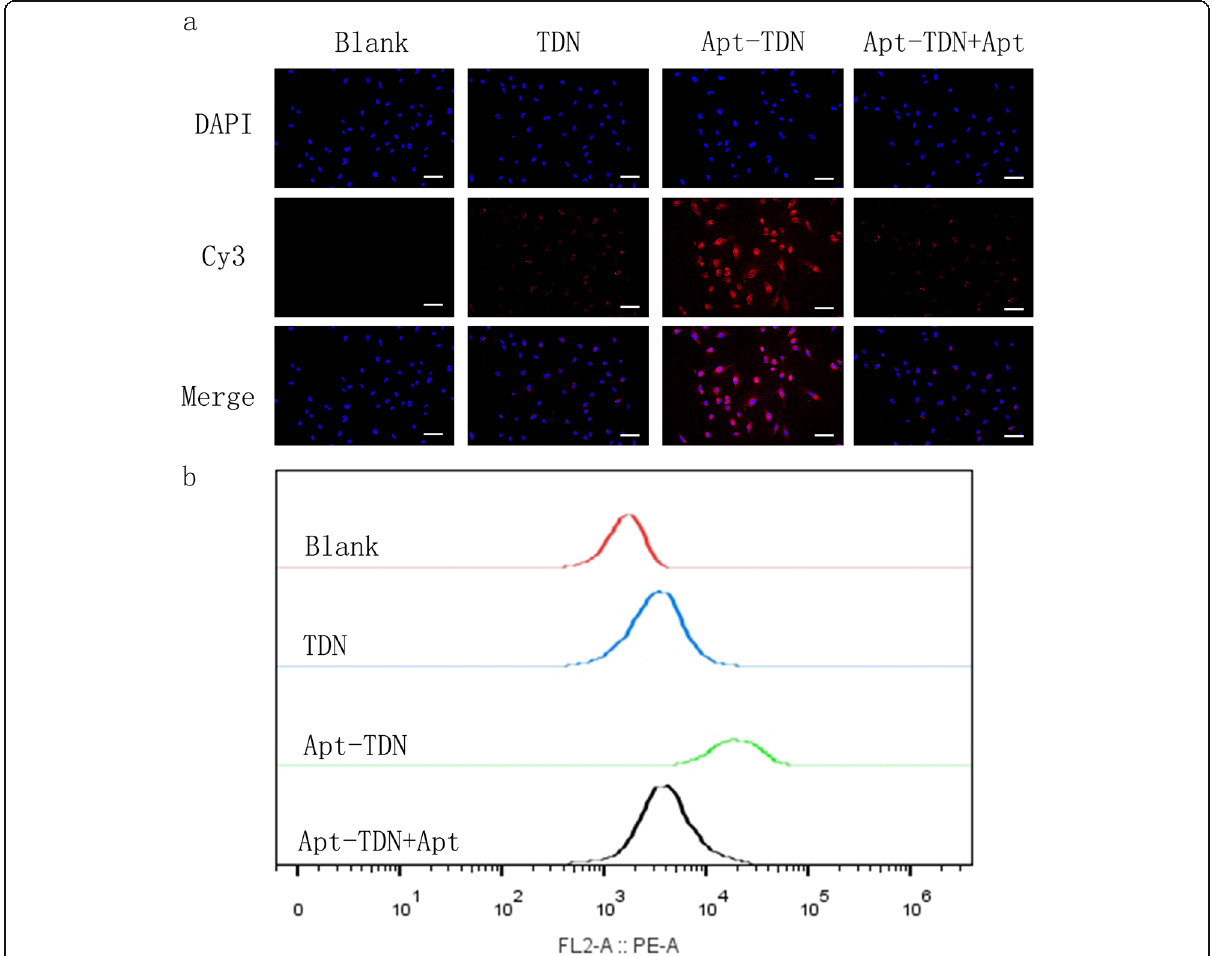
Fig. 4 a U87MG cell uptake of the TDN and Apt-TDN (TDN-Gint4.T). The TDN entered U87MG cells directly without transfection agents, and the uptake of Apt-TDN (linked to the aptamer Gint4.T) was significantly increased and competitively inhibited by free Apt (Gint4.T), indicating that the aptamer Gint4.T plays a significant role in cellular targeting. The scale bar represents 50 μ m. b Flow cytometry curves show the intracellular uptake of the TDN, Apt-TDN, and Apt-TDN+Apt after incubation for 3